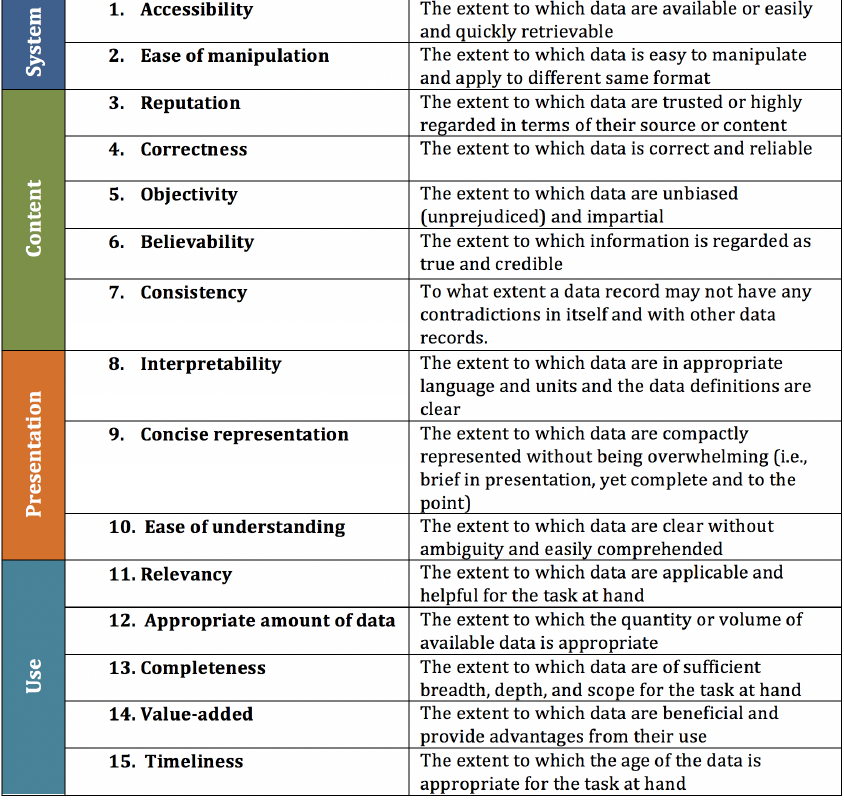
Figure 7. Data quality dimensions